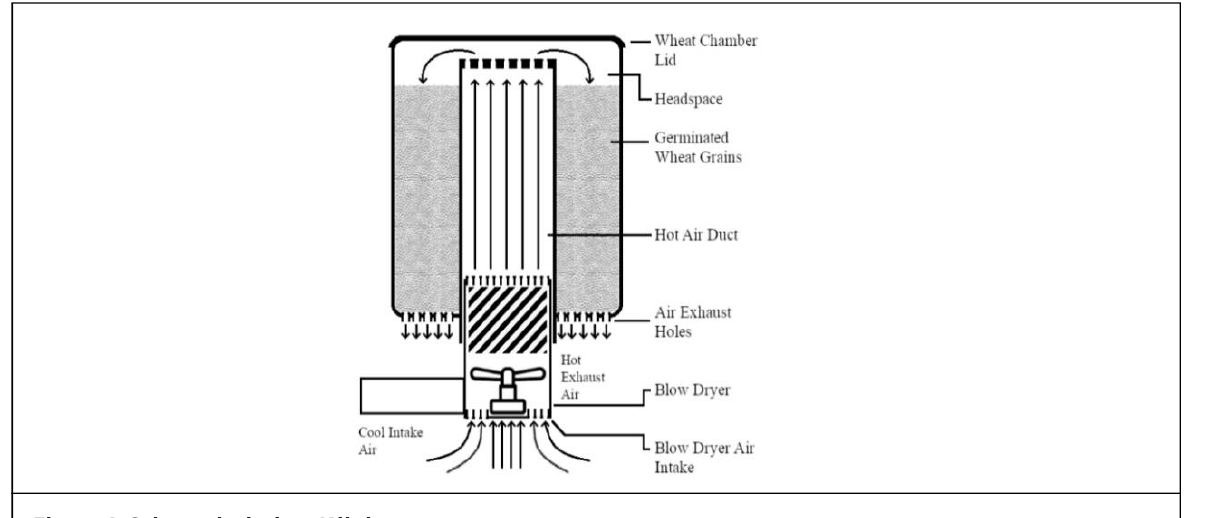
Figure 1: Schematic design: Kilning